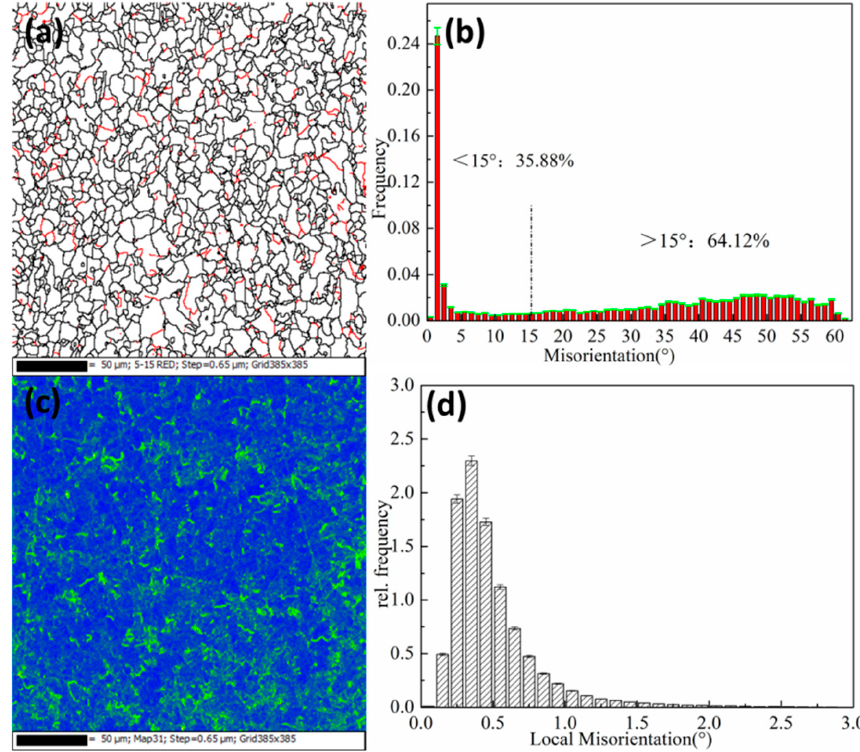
Figure 11. Grain boundary map and local orientation difference at 750 °C. ( a , b ) Grain boundary maps; ( c , d ) Local orientation difference.